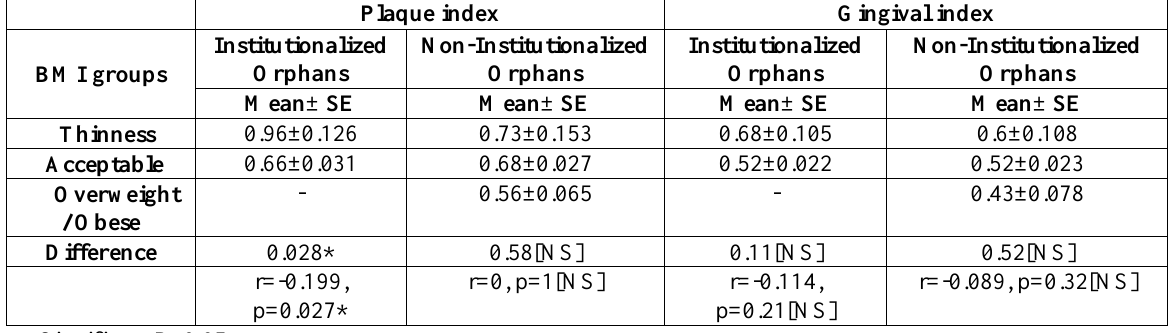
Table 4: Difference in CALI (median and mean rank) among the groups. CALI *Significant P<0.05 . Table 5: The difference in mean PLI and GI among BMI for age Z score groups of institutionalized and non-institutionalized orphans.